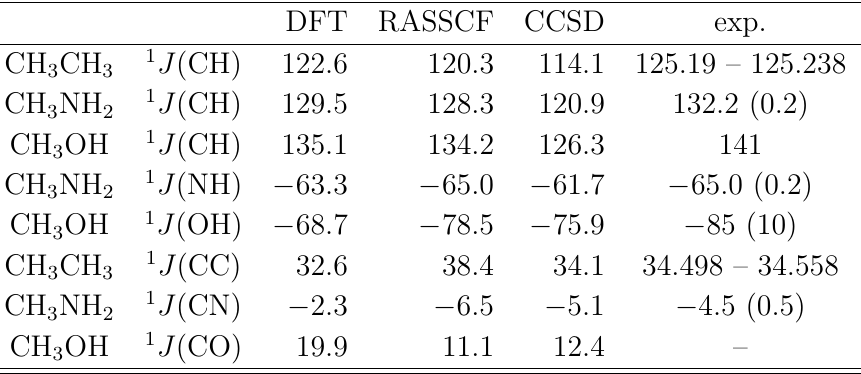
Table 1: Comparison of the total one-bond coupling constants calculated at the DFT, RASSCF a and CCSD levels with experiment.